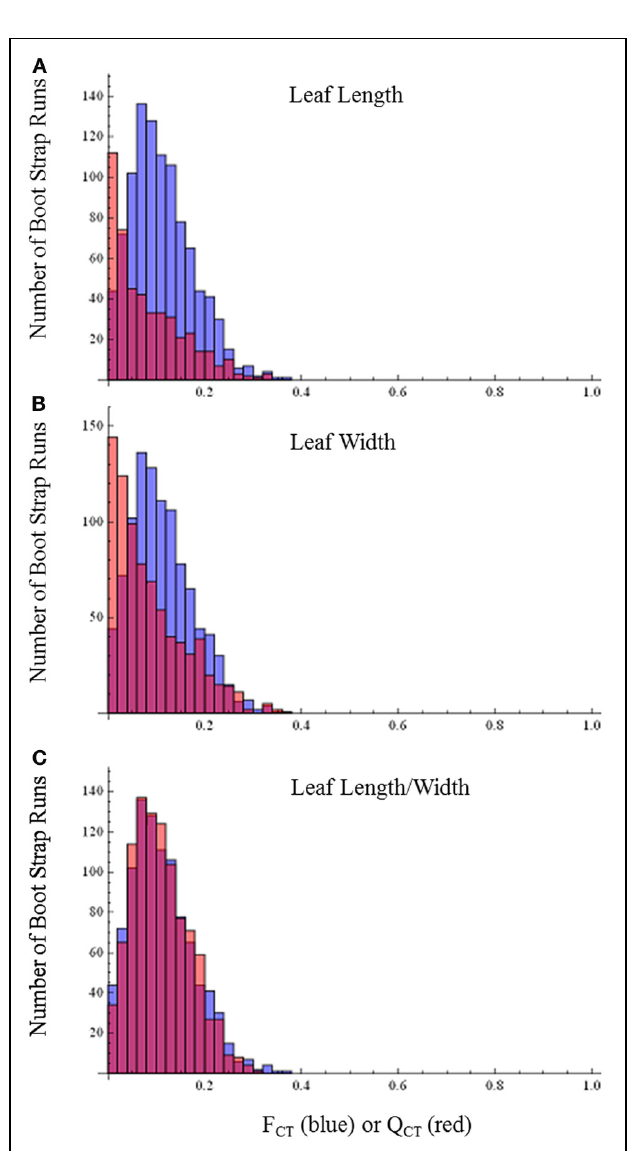
FIGURE 5 | F CT vs. Q CT analyses (A) leaf length ( p = 0 . 80) (B) leaf width ( p = 0 . 64) (C) leaf length-width ratio ( p = 0 . 44). Orange bars indicate portion of red bar that does not overlap blue